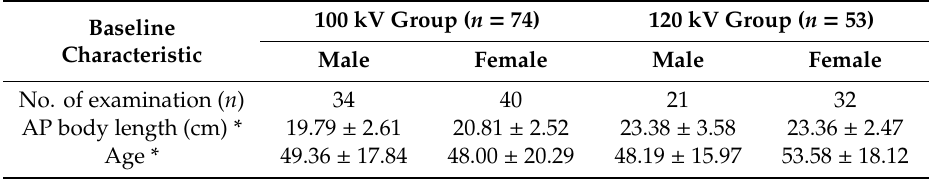
Table 1. Data on the baseline characteristics based on gender.